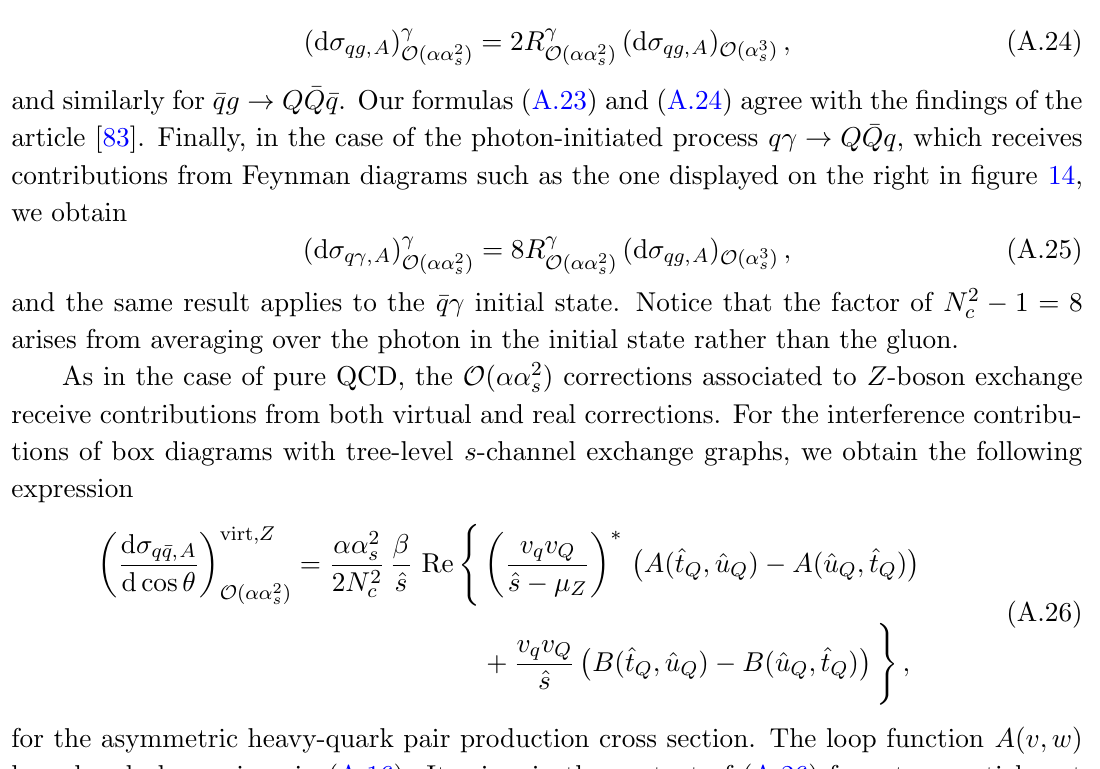
Figure 14 . Left: possible two- and three-particle cuts that contribute via q (cid:22) q ! Q (cid:22) Q , q (cid:22) q ! Q (cid:22) Qg and q (cid:22) q ! Q (cid:22) Q(cid:13) to the asymmetric cross section in heavy-quark production at O ( (cid:11)(cid:11) 2 example of a Feynman diagram that leads to a photon-initiated production asymmetry of heavy quarks at O ( (cid:11)(cid:11) 2 s